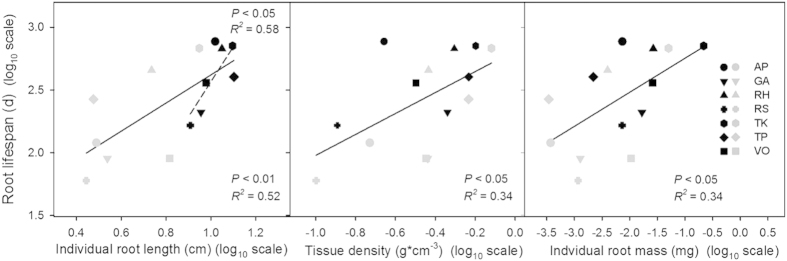
Regression plots of root traits (root tissue density, individual root length and mass) and root lifespan of basal and secondary roots on a log10 scale.Solid lines are the regression lines of root traits and root lifespan of basal and secondary roots (N = 14).The dashed line is the regression line of individual root length and root lifespan of basal roots only (N = 7). Symbols in black represent basal roots and symbols in gray represent secondary roots.